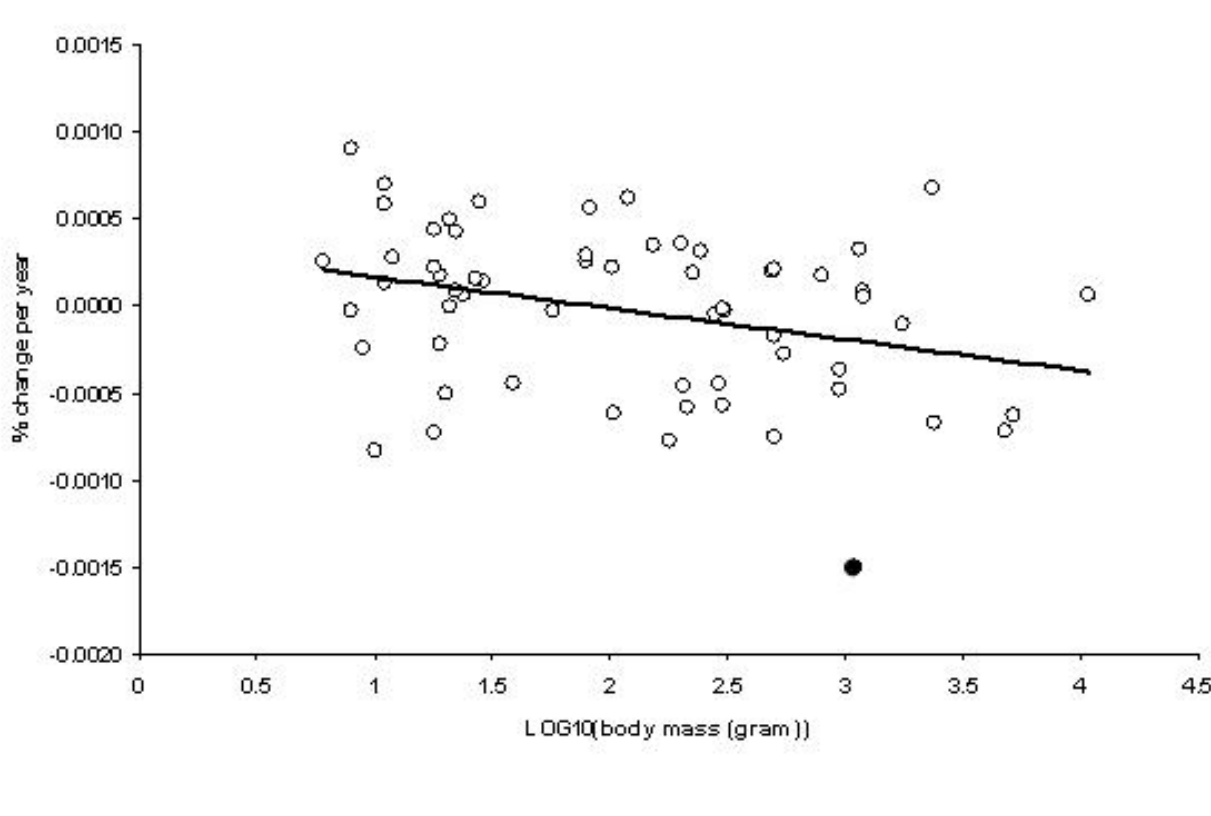
Fig. 1 . Annual rate of change in body length (% of present body length) in 61 Danish breeding birds, 1796 – 1978, versus present body mass. Also given is the regression line (Y = 0.000342 - 0.000178X). The black dot indicates the rate of change for Black Grouse ( Tetrao tetrix